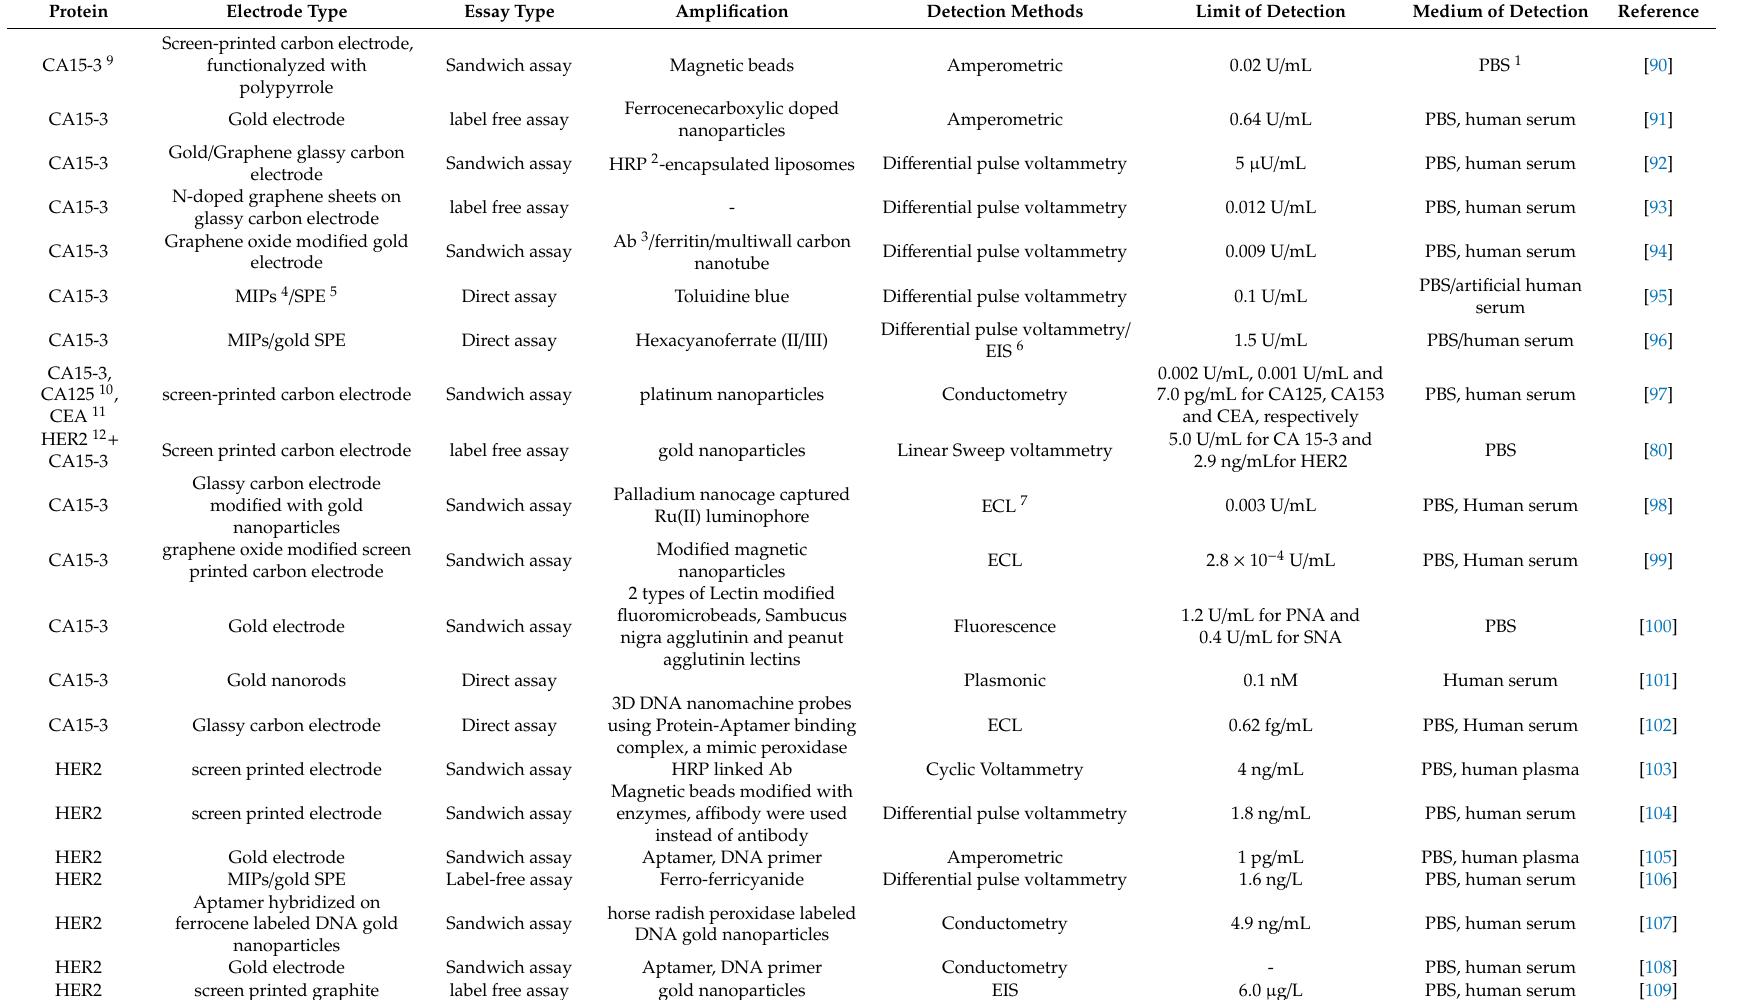
Table 3. List of a ffi nity sensors (AS) for the detection of BC protein